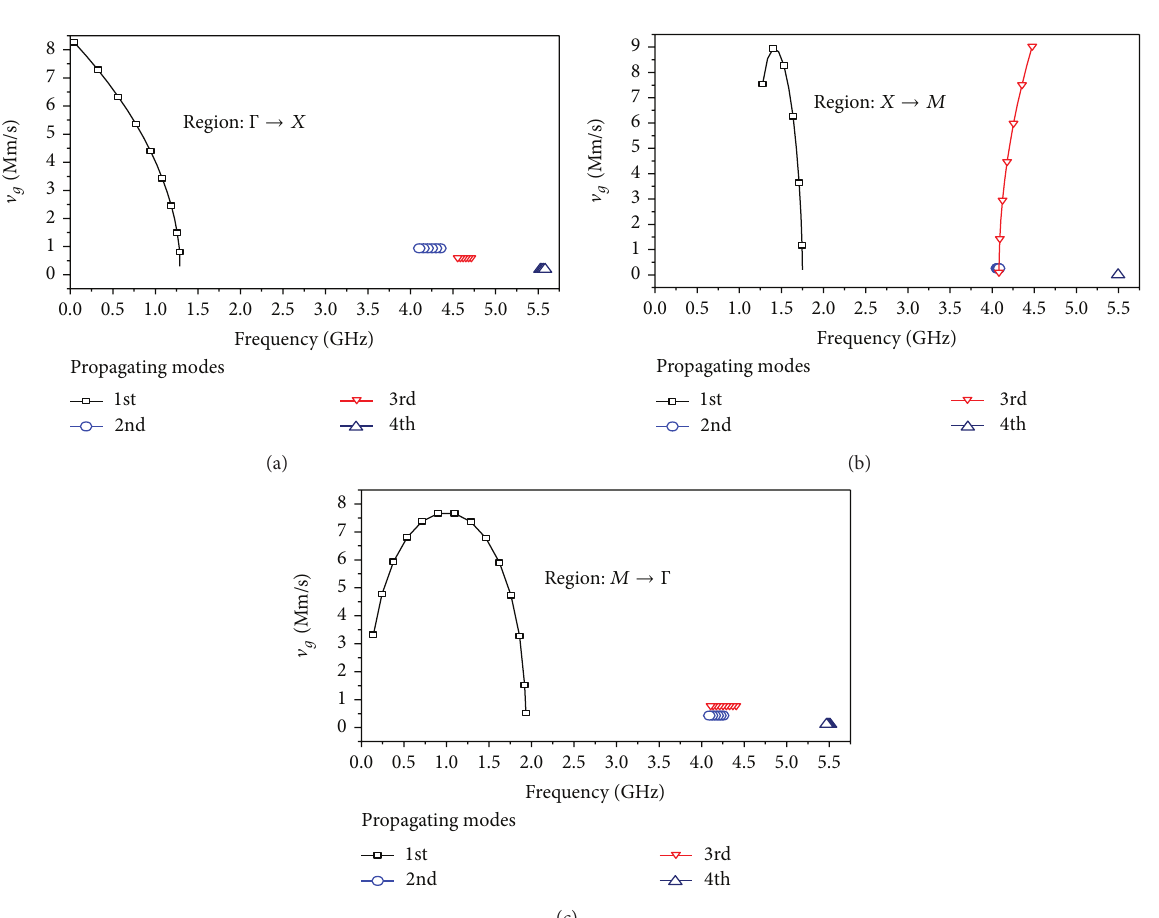
Figure 3: Group velocity V 𝑔 of the propagating modes of the EBG sample in irreducible Brillouin zone. The V 𝑔 graphs are obtained from the propagating-mode-polynomial fits presented in Figure 2.